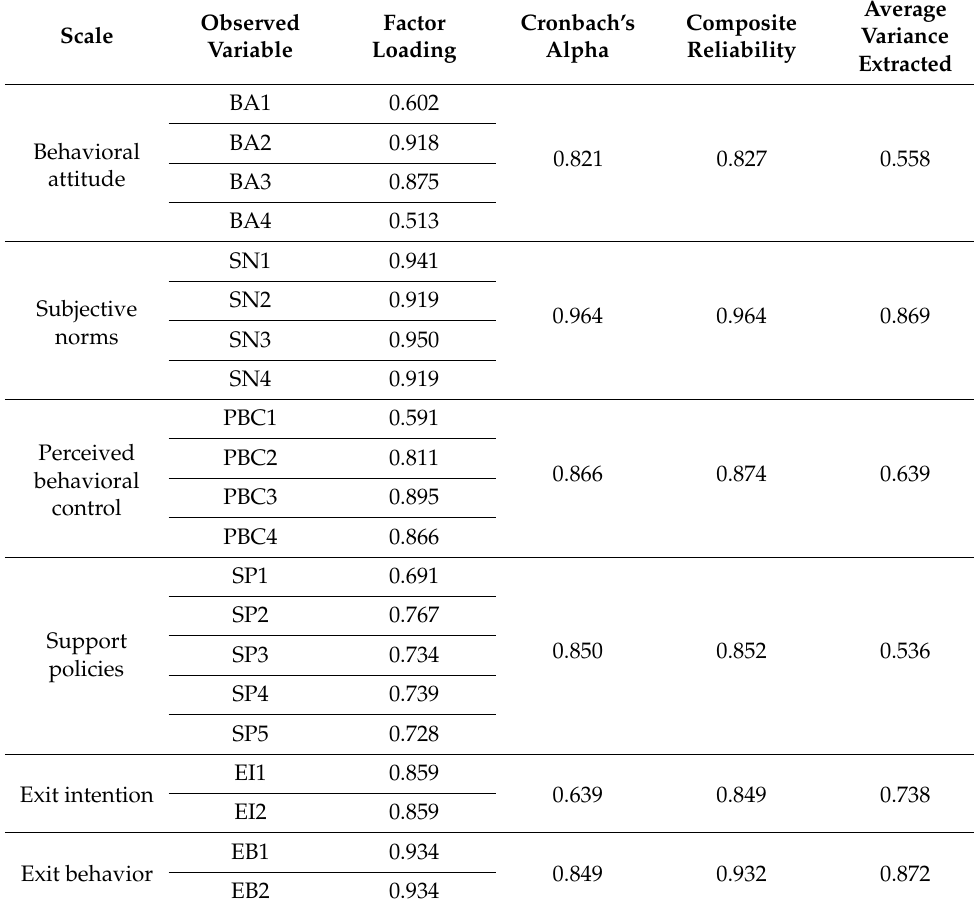
Table 3. Reliability and validity of the